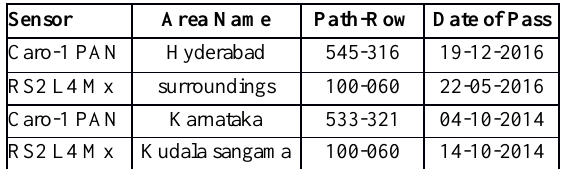
Table 2: Details of the Data sets used